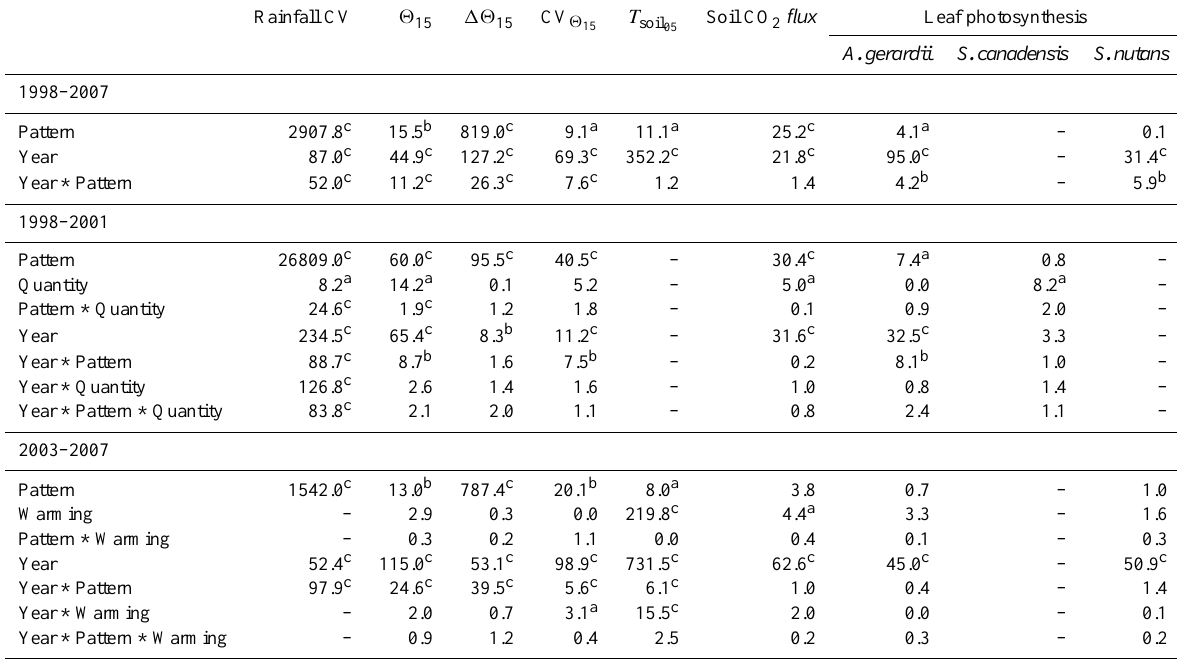
Table A1. Analysis of variance F statistics for rainfall and soil moisture variation responses to pattern, quantity, and warming treatments in RaMPs.